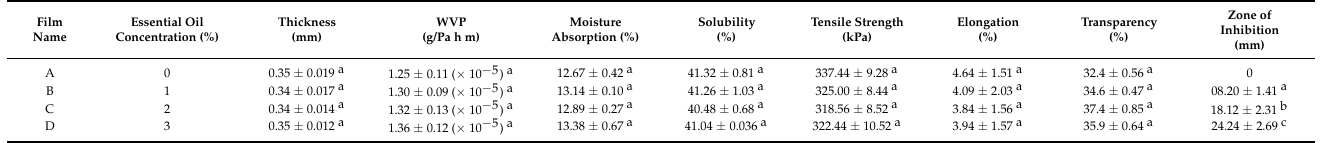
Table 1. Properties of sweet lime peel residue-based film added with sweet lime essential